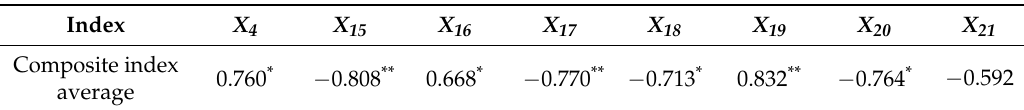
Table 4. Pearson correlation coefficient between the WRSCI average value and constant indicators of each city and state in Guizhou